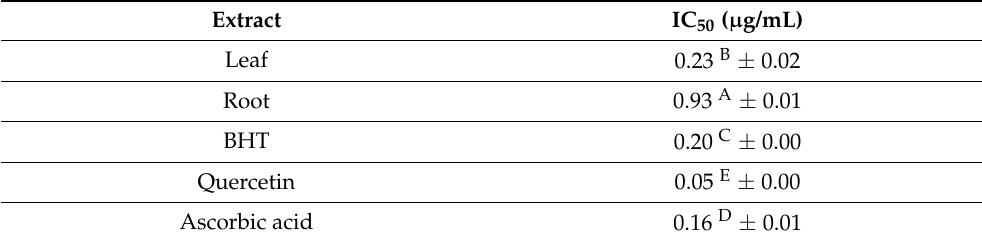
Table 3. DPPH antioxidant test result represented by IC 50